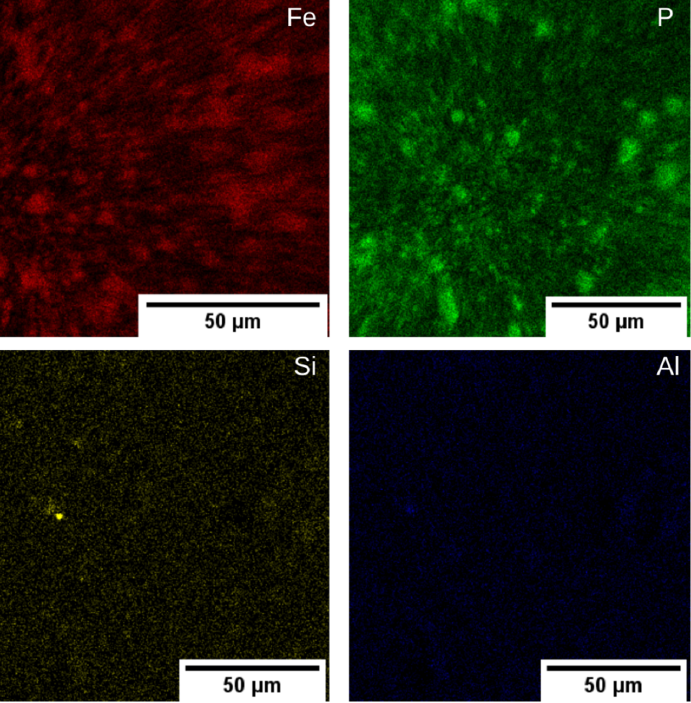
Figure 7. Elemental distribution of the most important elements in the solid residue after sulfuric acid leaching at a concentration of 0.32 mol/L, 15.2 vol% of oxidizing agent (H 2 O 2 ), S/L ratio of 50.75 g ∙ L − 1 at 30 °C, and a leaching time of 30 min. 50.75 g · L − 1 at 30 ◦ C, and a leaching time of 30